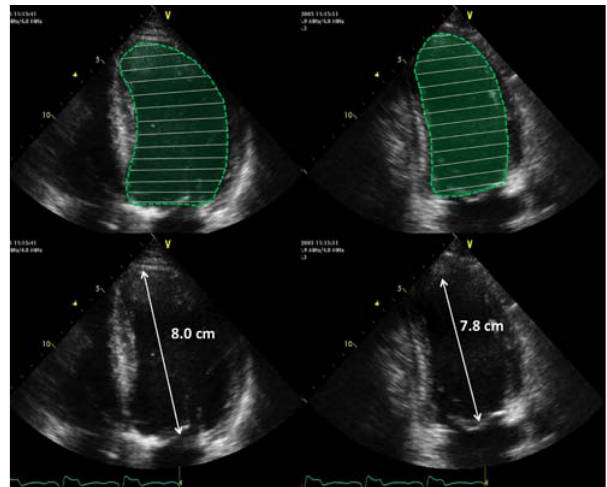
Figure 10: Schematic representation of the biplane disc summation algorithm based on the measurement of left ventricular areas and long axis lengths on 4- and 2-chamber two-dimensional views of the left ventricle. To obtain accurate calculation of left ventricular volume the difference between the long axes measured in 4- and 2- chamber apical views should not be larger than